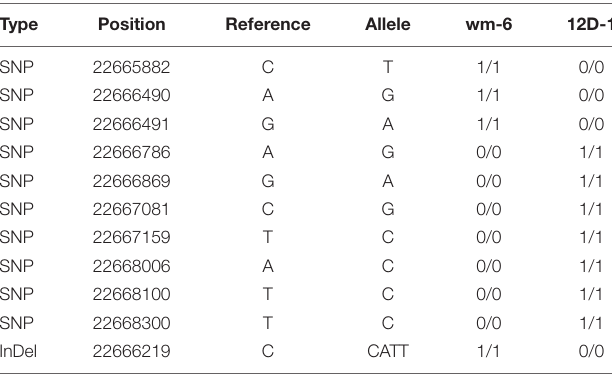
TABLE 5 | Analysis of SNPs and InDels present within the MELO3C002434 gene in two parental melon lines.